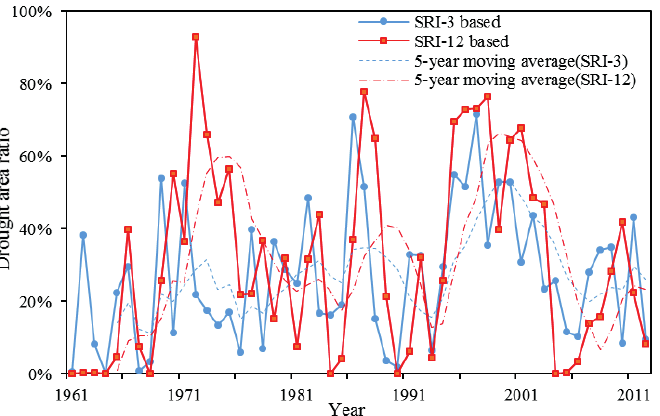
Fig. 3 Drought area ratio from 1961 to 2012, based on 3- and 12-month gridded